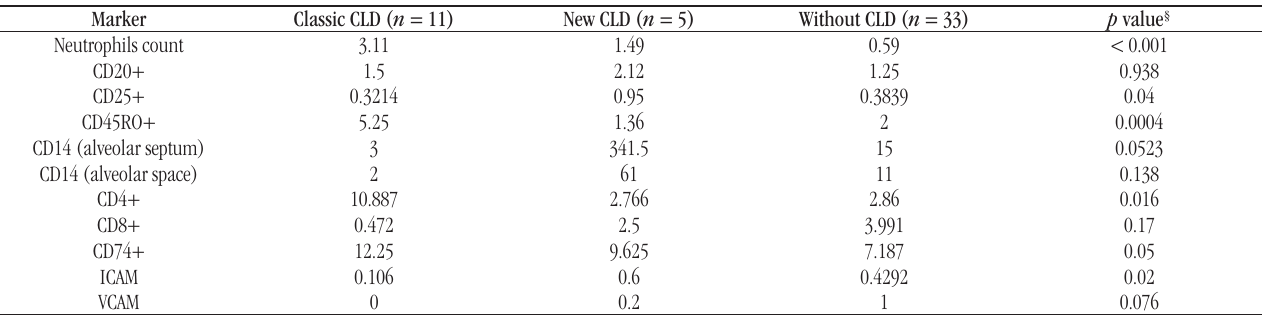
VCAM: vascular cell adhesion molecule; ICAM-1: intercellular adhesion molecule-1; CLD: chronic lung disease; § : Kruskal-Wallis non-parametric test ( p < 0.05); p value is between classic and without CLD and new and without